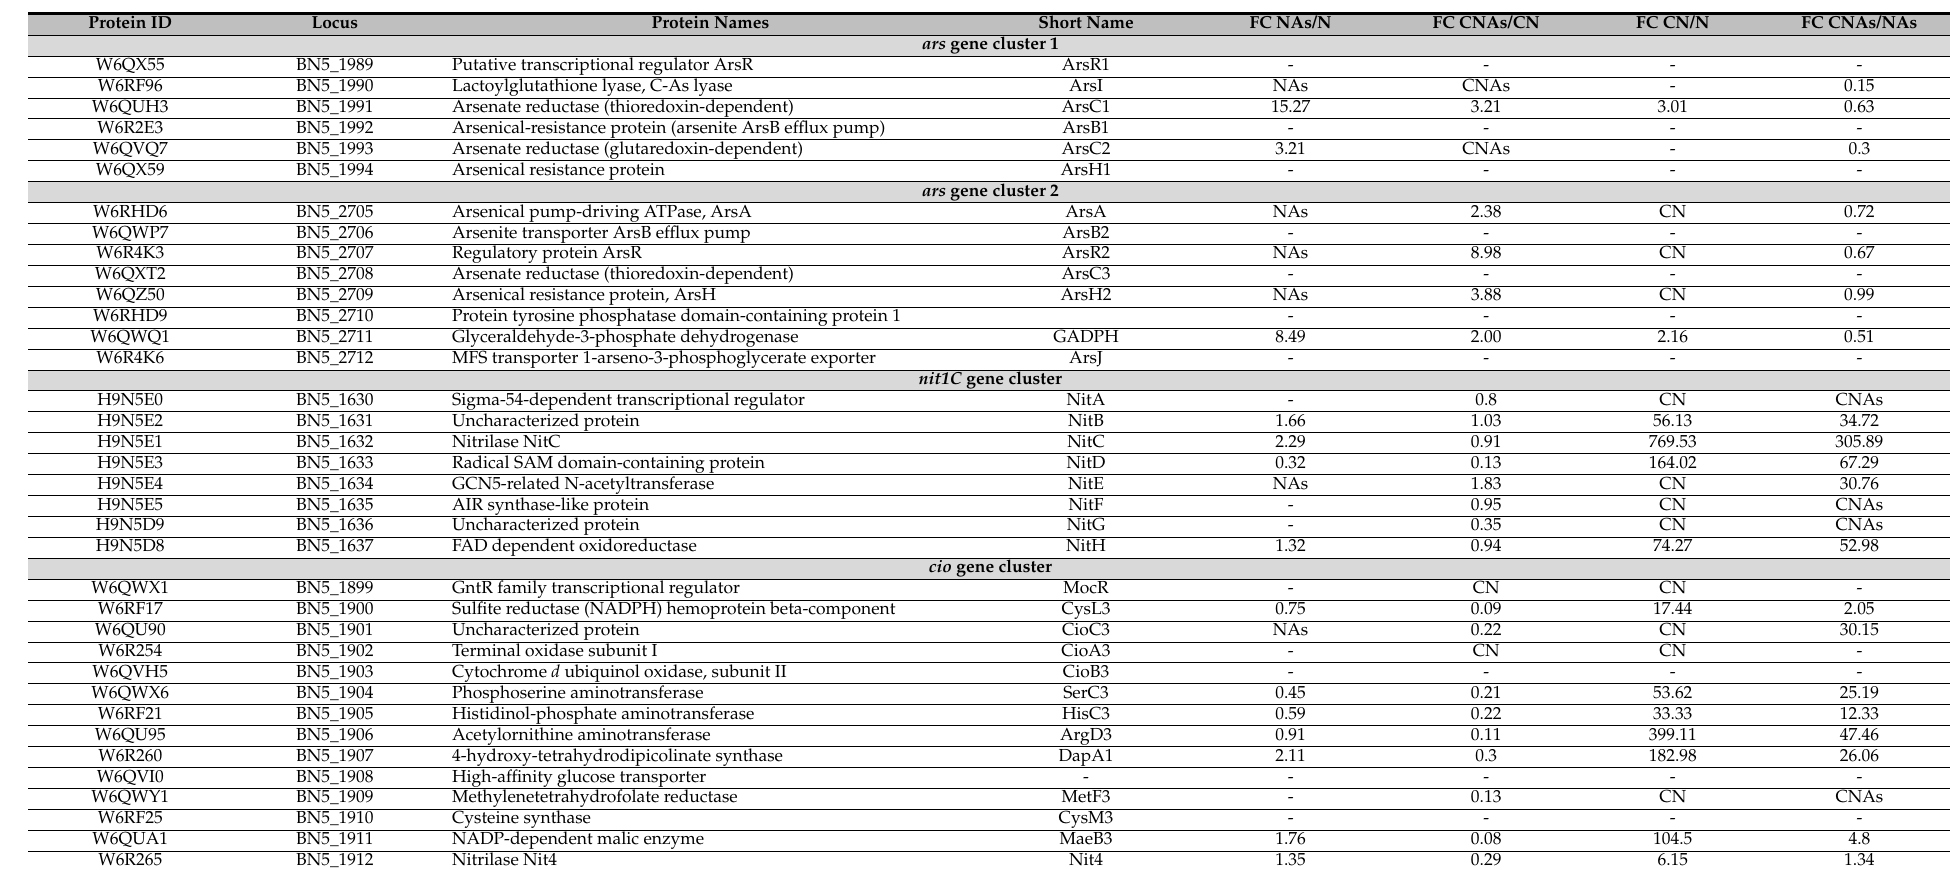
Table 1. Proteomic analysis of proteins with a possible role in arsenic and/or cyanide detoxification. Relative label-free quantification (LFQ) intensity was used to calculate the FC in the four comparisons NAs/N, CNAs/CN, CN/N, and CNAs/NAs. NAs, ammonium as N-source, with 0.25 mM arsenite; N, ammonium as N-source, without arsenite; CNAs, cyanide as N-source, with 0.25 mM arsenite; and CN, cyanide as N-source, without arsenite. Proteins exclusively found in a condition are indicated with the name of that condition. Proteins not detected